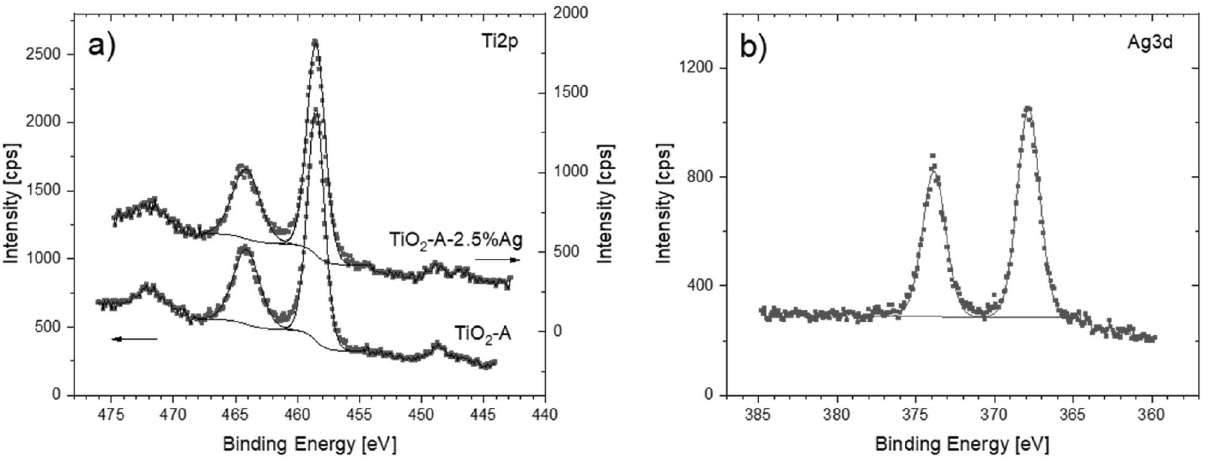
Figure 11. High resolution XPS spectra of Ti2p ( a ) and Ag3d ( b